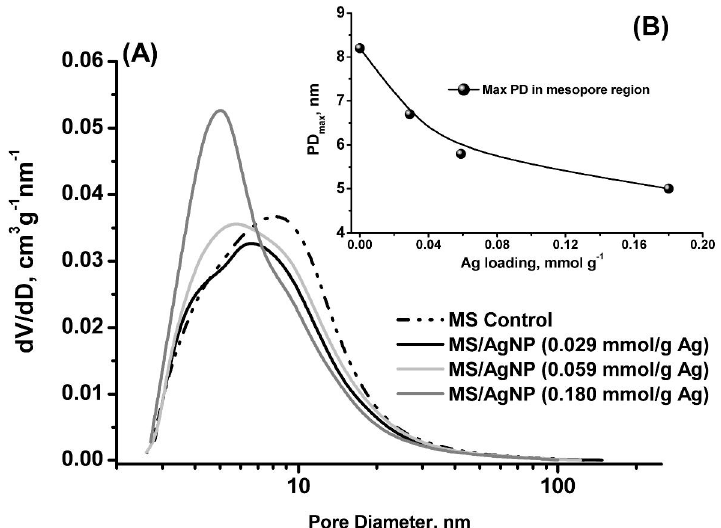
Figure 3. ( A ) Pore size distributions of MS and MS/AgNP materials prepared at increasing Ag loading; and ( B ) Relationship between pore diameter maximum in mesopore region and Ag